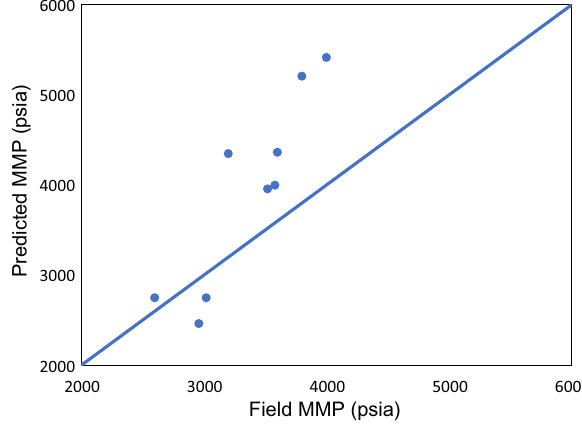
Fig. 8 Cross-plot of MMP testing data for Glaso (1985)